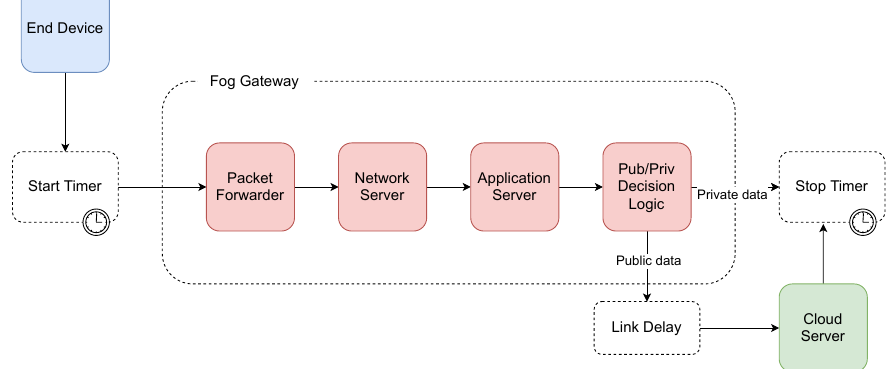
Figure 6. Diagram of the simulation model of architecture